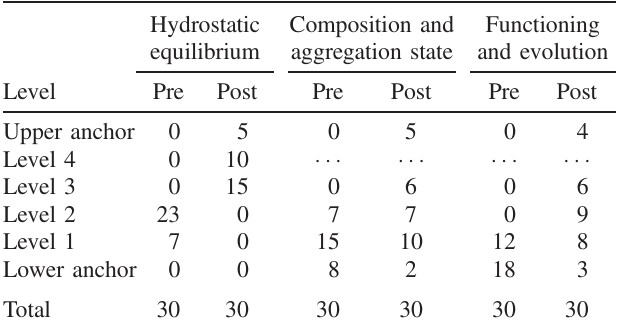
TABLE VI. Sample 3 students ’ distribution across LP2 levels.